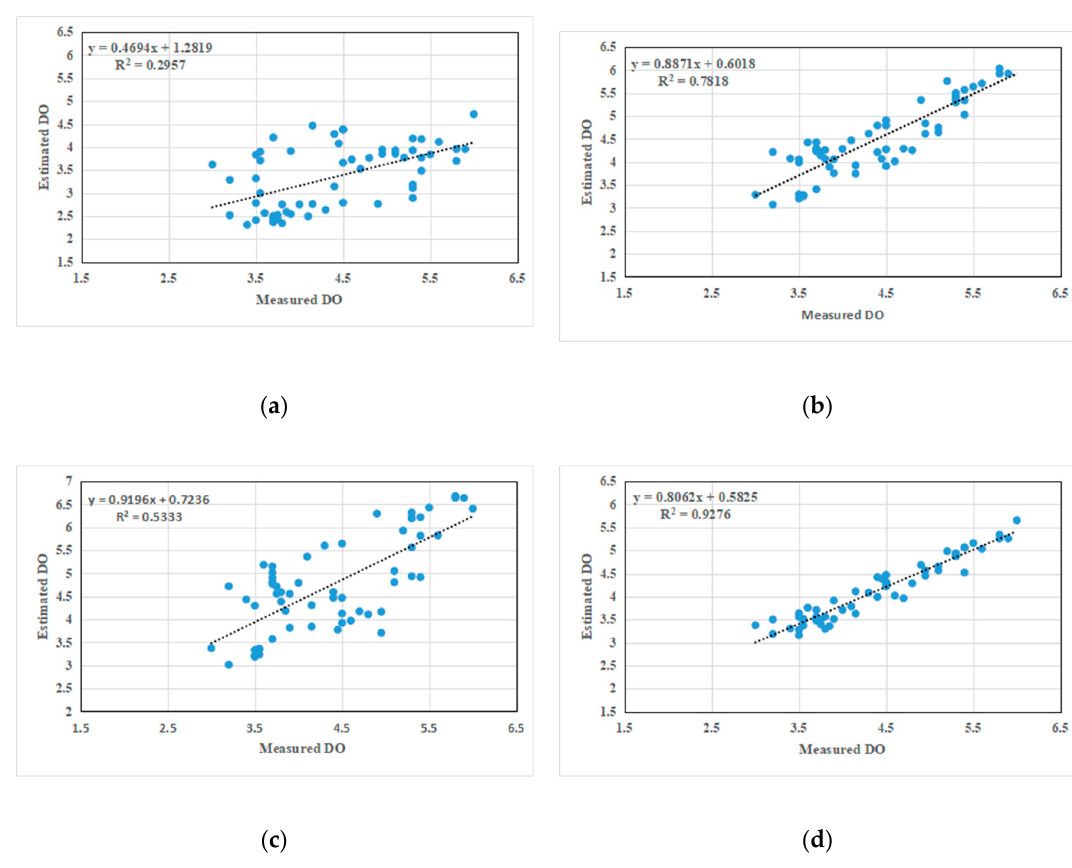
Figure 4. R 2 of the ( a ) BPNN, ( b ) PSO-BPNN, ( c ) GA-BPNN, and ( d ) PSO-GA-BPNN models. Figure 4. 𝑅 (cid:2870) of the BPNN, PSO-BPNN, GA-BPNN, and PSO-GA-BPNN models. 292